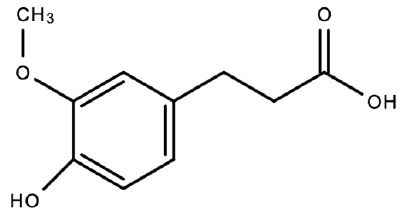
Figure 2. Ferulic acid structure.